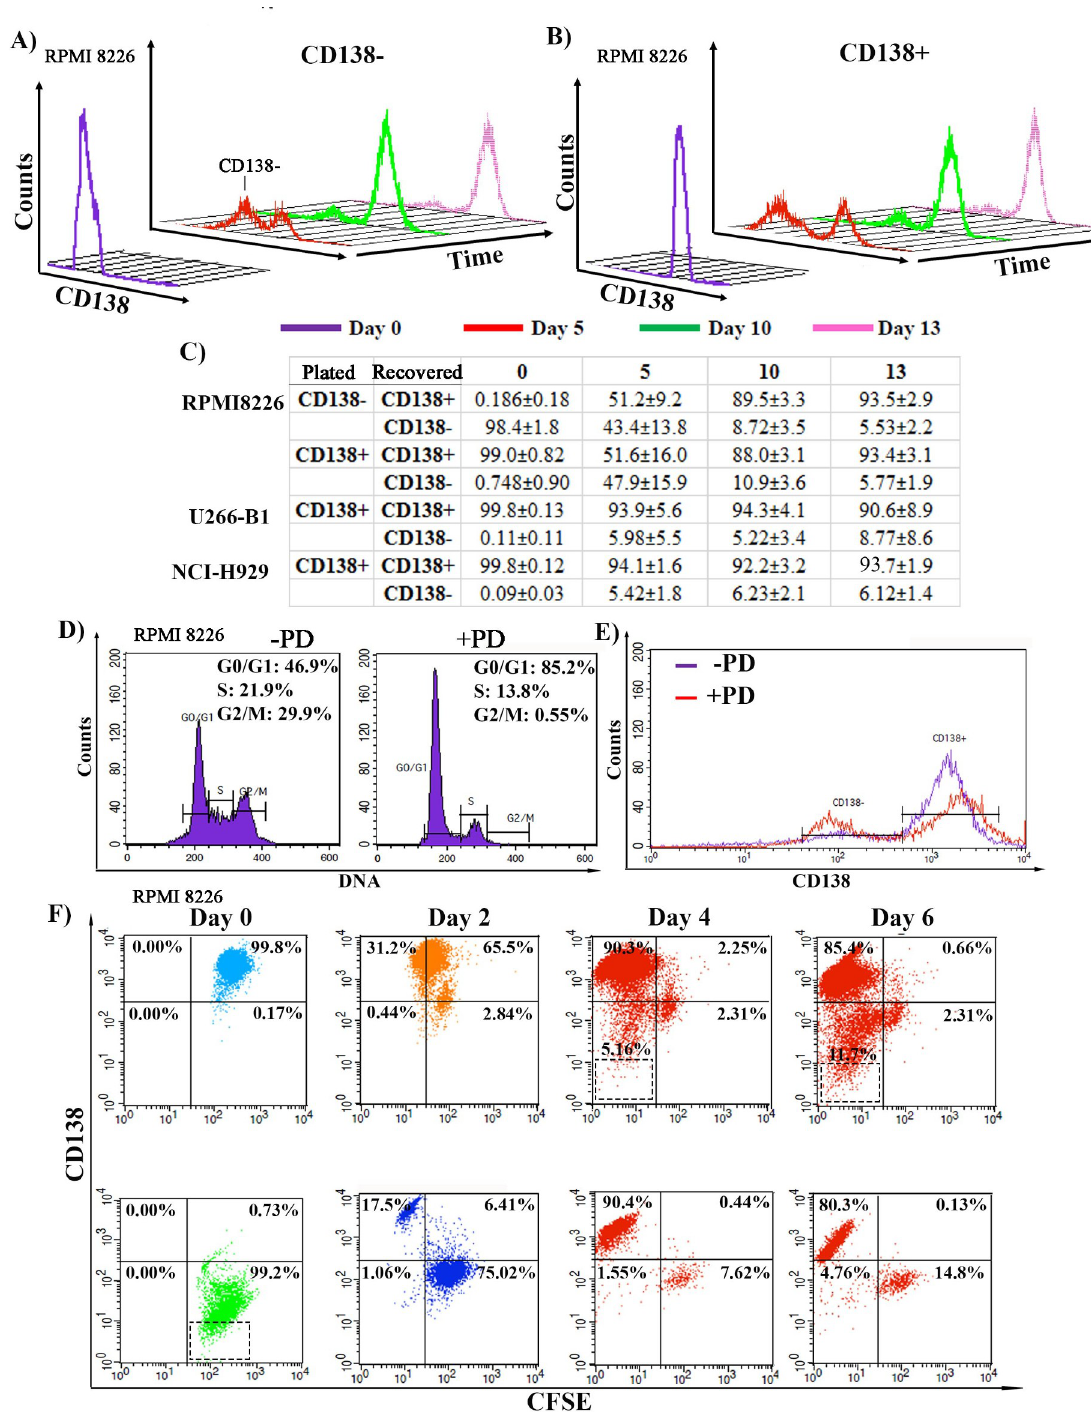
Fig 2. Plasticity of cells. A, B) Sorted CD138-CD38+ and CD138+CD38+ populations were plated, aliquots (10,000 cells) were analyzed for CD138 expression at days 5, 10, and 13. Purple line is CD138 content at time of plating (Representative of N = 5). Flow cytometry will not measure expansion of the cultures. C) Sorted CD138-CD38+ and CD138+CD38+ cells from U266-B1 and NCI-H929 MM lines plated and analyzed for CD138 status at days 5, 10 and 13. (N = 3, mean+/-SD) D) Cell Cycle status of RPMI8226 cells before (left) and after (right) treatment with 5 μ M PD0332991 (PD). E) CD138 expression of RPMI8226 cells before (purple) and after (red) PD treatment for 3 days. F) Cells were treated with 5 μ M PD for 3 days, stained with CFSE, washed, and then followed in culture for 6 days. Aliquots were analyzed for CFSE and CD138 over this time course. Dashed boxes are of non-viable cells (population iii) were not included in the overall percentages of each quadrant.